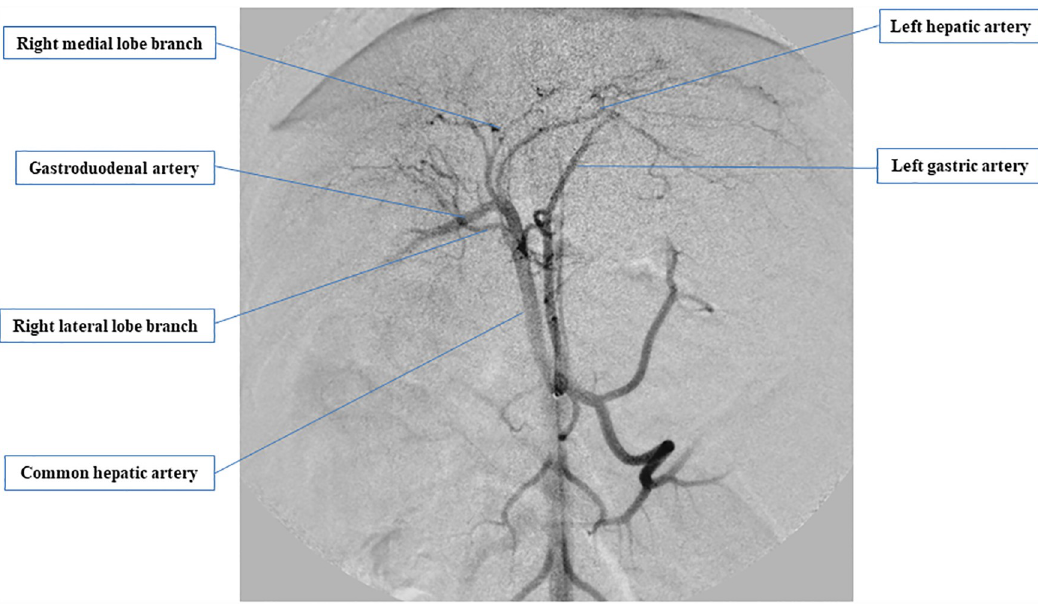
Fig 2. Ventral-dorsal digital subtraction images of a canine. Hepatic arteriogram was performed after the injection of contrast medium through a 4-French catheter placed in the common hepatic artery. We inserted a catheter in the left hepatic artery, right medial lobe branch, and right lateral lobe branch and injected bone marrow-derived mesenchymal stem cells (BMSCs) via each of these arteries at doses of 2 × 10 5 cell/kg, 1 × 10 5 cell/kg, and 1 × 10 5 cell/kg, respectively.